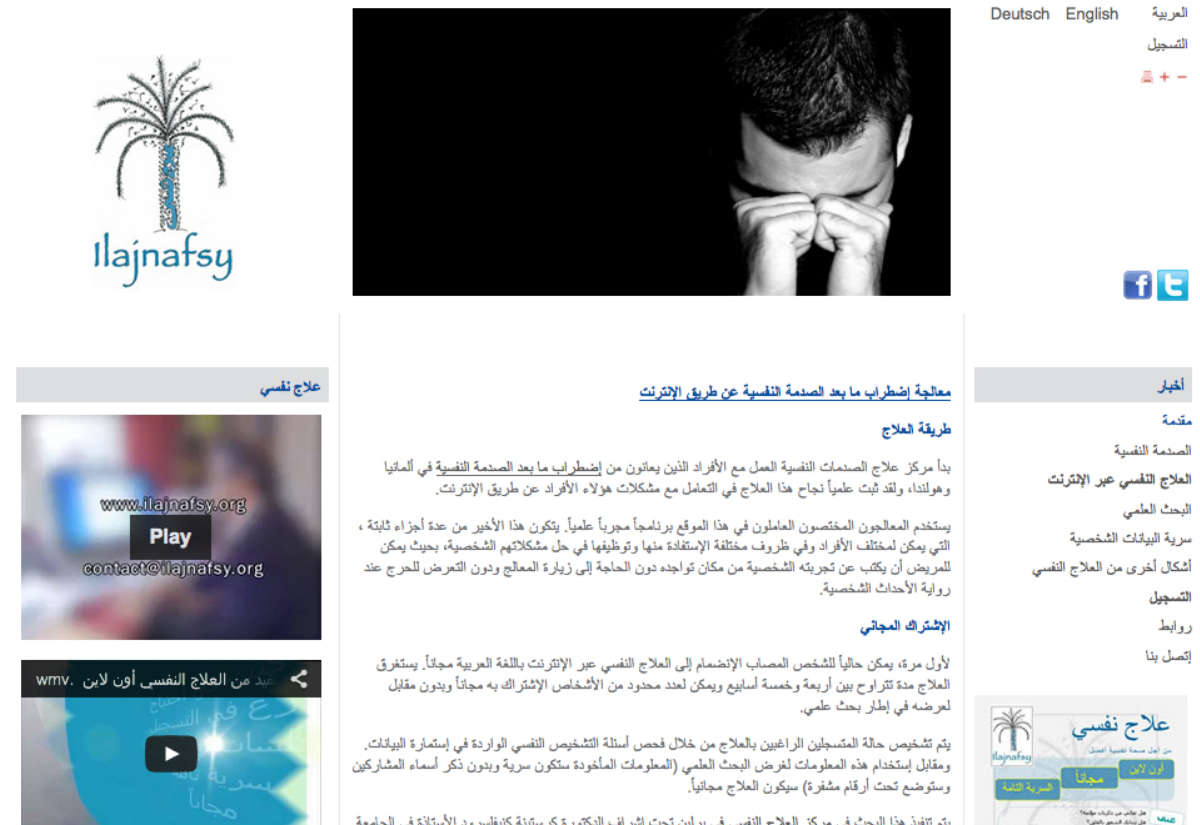
Figure 2. Screenshot